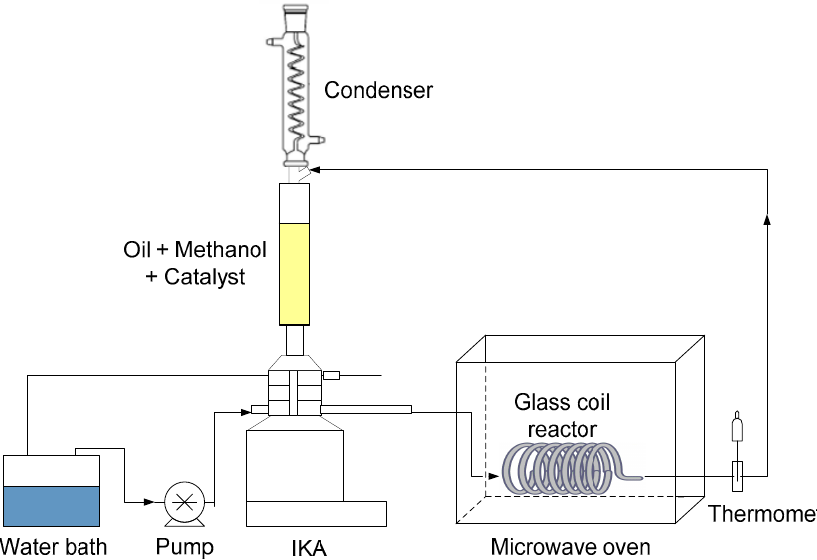
Figure 2. Integrated flow reactor that combines high-shear mixing and MW irradiation for biodiesel production [15].